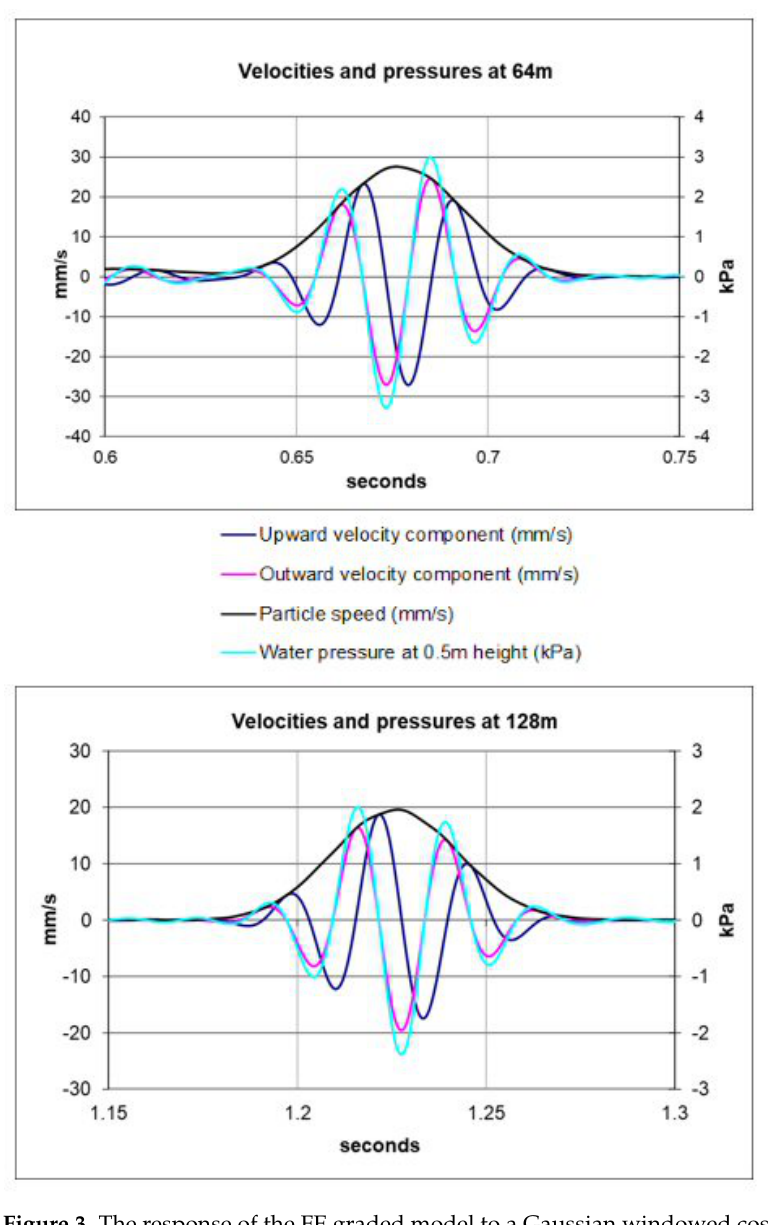
Figure 3. The response of the FE graded model to a Gaussian windowed cosine impulse is shown at two positions, each plotted against time. The two velocity components (upward (dark blue) and outward (mauve)) are combined to show the vector magnitude, the particle speed (black). The pressures (light blue) at this height (0.5 m above the seabed) matched the shape of the outward velocity component.